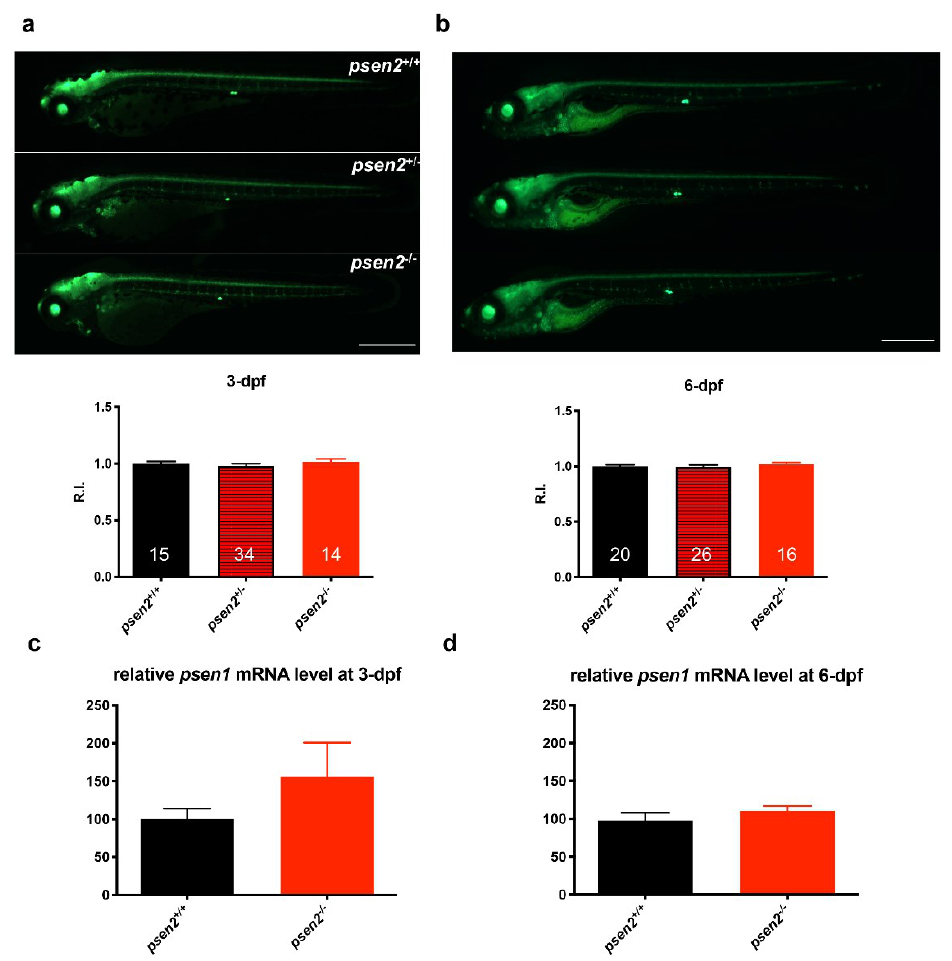
Figure 2. Effect of Psen2 absence on Notch signaling and psen1 expression at early developmental stages. ( a , b ) Representative images and relative fluorescence quantification of psen2 +/ − incross progeny in Tg(EPV.Tpi–Mmu.Hbb: EGFP) ia 12 transgenic background, both at ( a ) 3- and ( b ) 6-dpf. Genotyping was performed after image acquisition. Values represent the mean ± SEM. Data were generated from 3 independent experiments. R.I. = Relative Intensity. Scale bar: 500 µ m. Statistical significance was determined by one-way ANOVA test. ( c , d ) Quantification of relative psen1 mRNA in both ( c ) 3- and ( d ) 6-dpf psen2 +/+ and psen2 – / – larvae. Values represent the mean ± SEM. Data were generated from 3 biological replicates for each condition. Statistical significance was determined by two-tailed Student’s t-test.